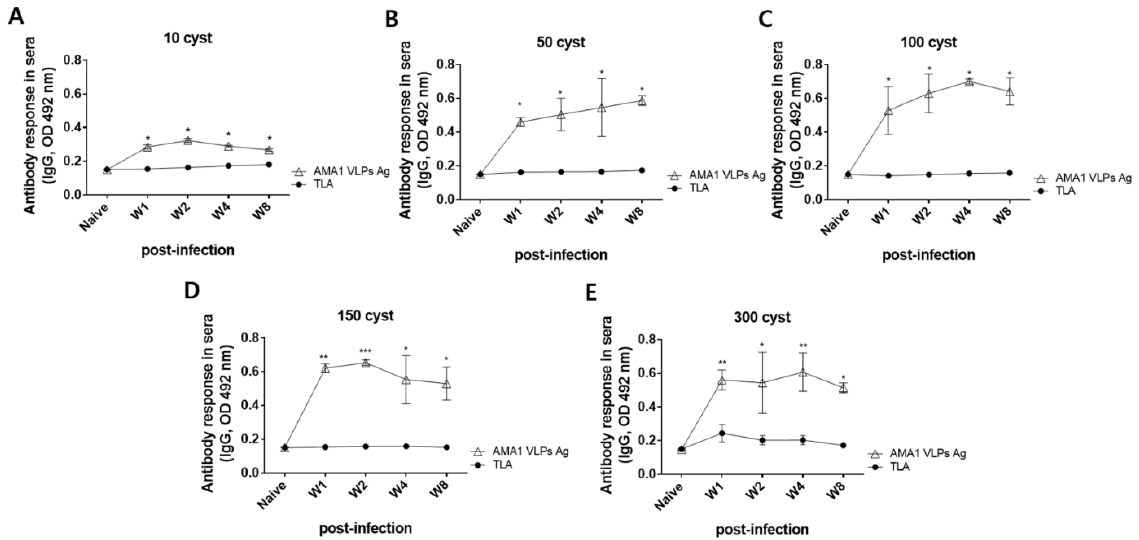
Figure 2. Reactivity of T. gondii ME49 infection-induced IgG antibody response to TLA and AMA1 VLPs. Mice were orally infected with 10 ( A ), 50 ( B ), 100 ( C ), 150 ( D ), or 300 ( E ) cysts of the T. gondii